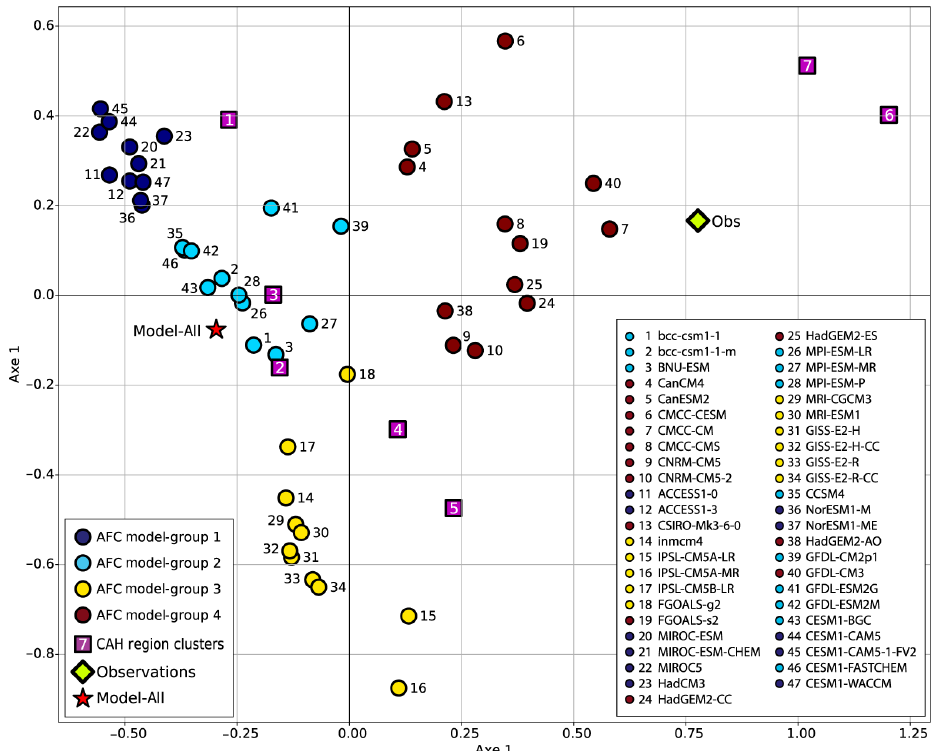
Figure 4. Projection of the CMIP5 models (colored circles) and the observation field (green diamond) defined by their cluster skill vectors onto the first two axes of the MCA. The seven region clusters of the observation field are represented by purple squares. The colors of the circles denote the four groups of models obtained after an HAC was performed on the seven MCA components of the models. The projection of the full multi-model mean (47 models) is represented by a red star. We note that some bias can be introduced into this projection since the projection onto the other axes can be of